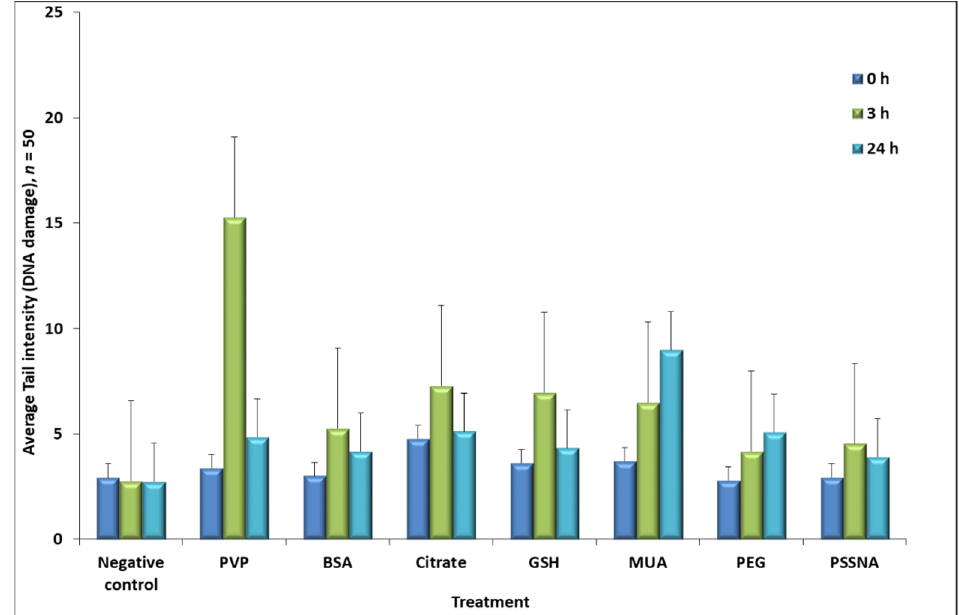
Figure 5. Comet assay average tail intensity for each of the GNP-ligand IC 30 concentrations at the 0 h, 3 h, and 24 h time points. Table 3. Overall percentage of DNA damage induced by the GNP-ligands.